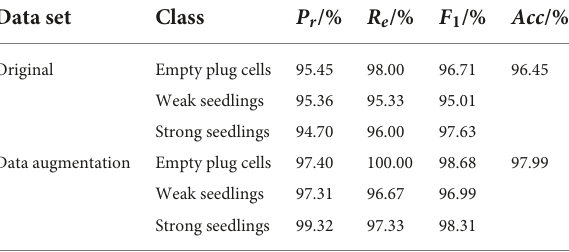
TABLE 3 Performance of the model before and after data augmentation.